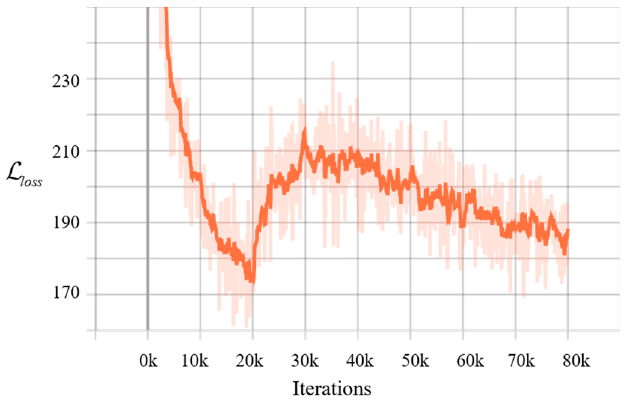
Figure 5. Training loss with KL annealing. Weight β gradually increases from 0 to 1 between 20 k to 80 k iterations.